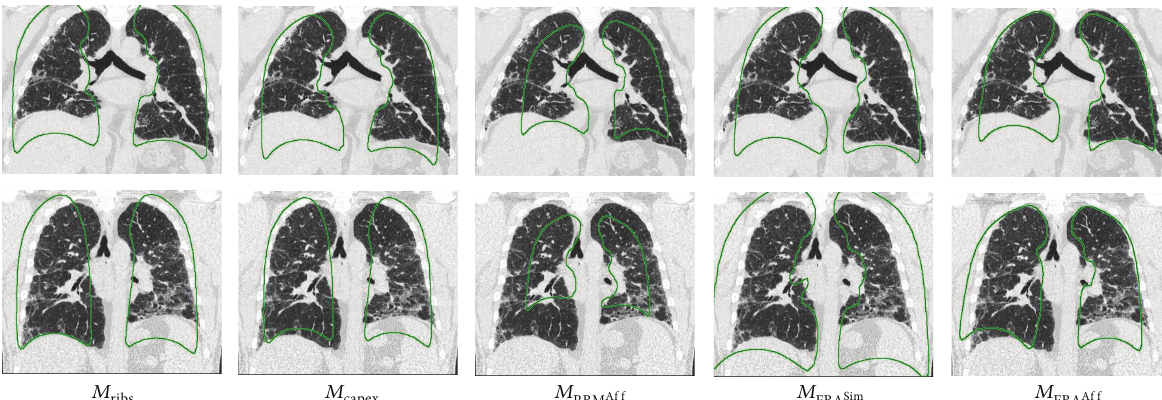
shows initialization quite close to the target FBA Aff